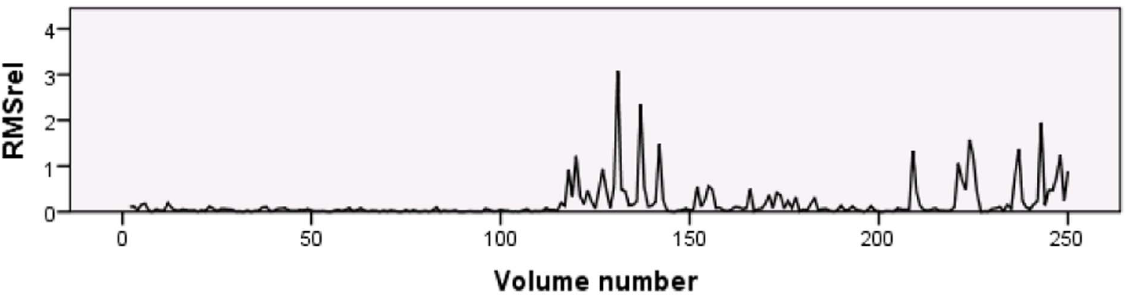
Figure 3. RMS rel rfMRI time-series of subject 11. Subject 11 showed an obvious increase in motion during the second half of the rfMRI scan.